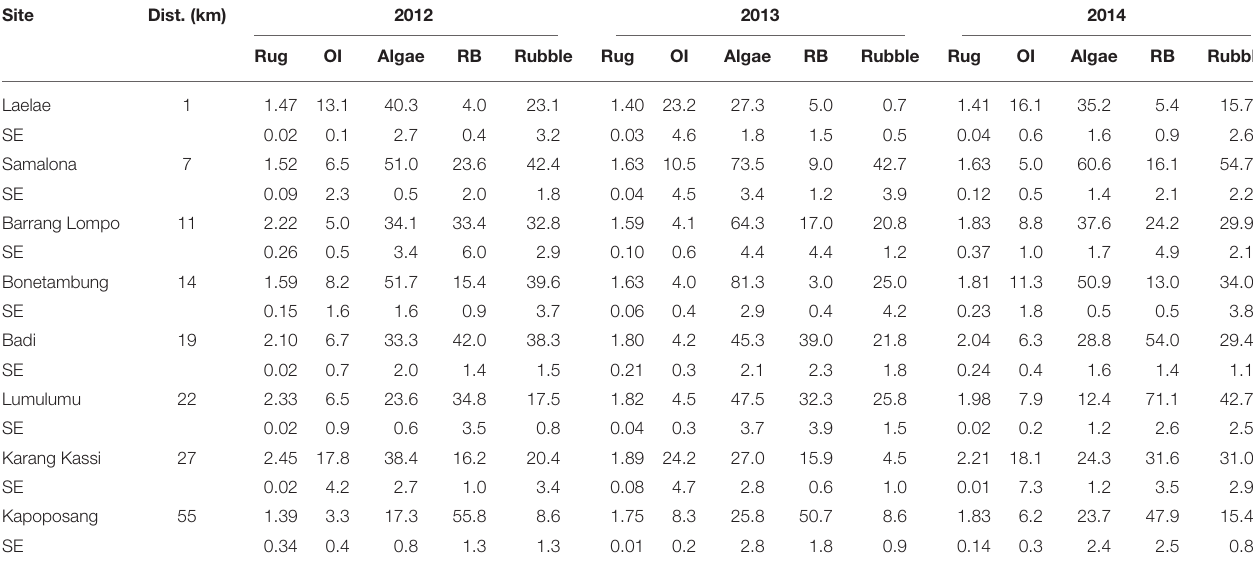
TABLE 2 | Average (% ± SE) cover of benthic functional groups [OI, other invertebrates (sponges, tunicates, etc.), Algae (macroalgae + turf algae), RB, reef builders (live coral + CCA), Rubble] and structural complexity (Rug = rugosity). Site Dist. (km) OI RB